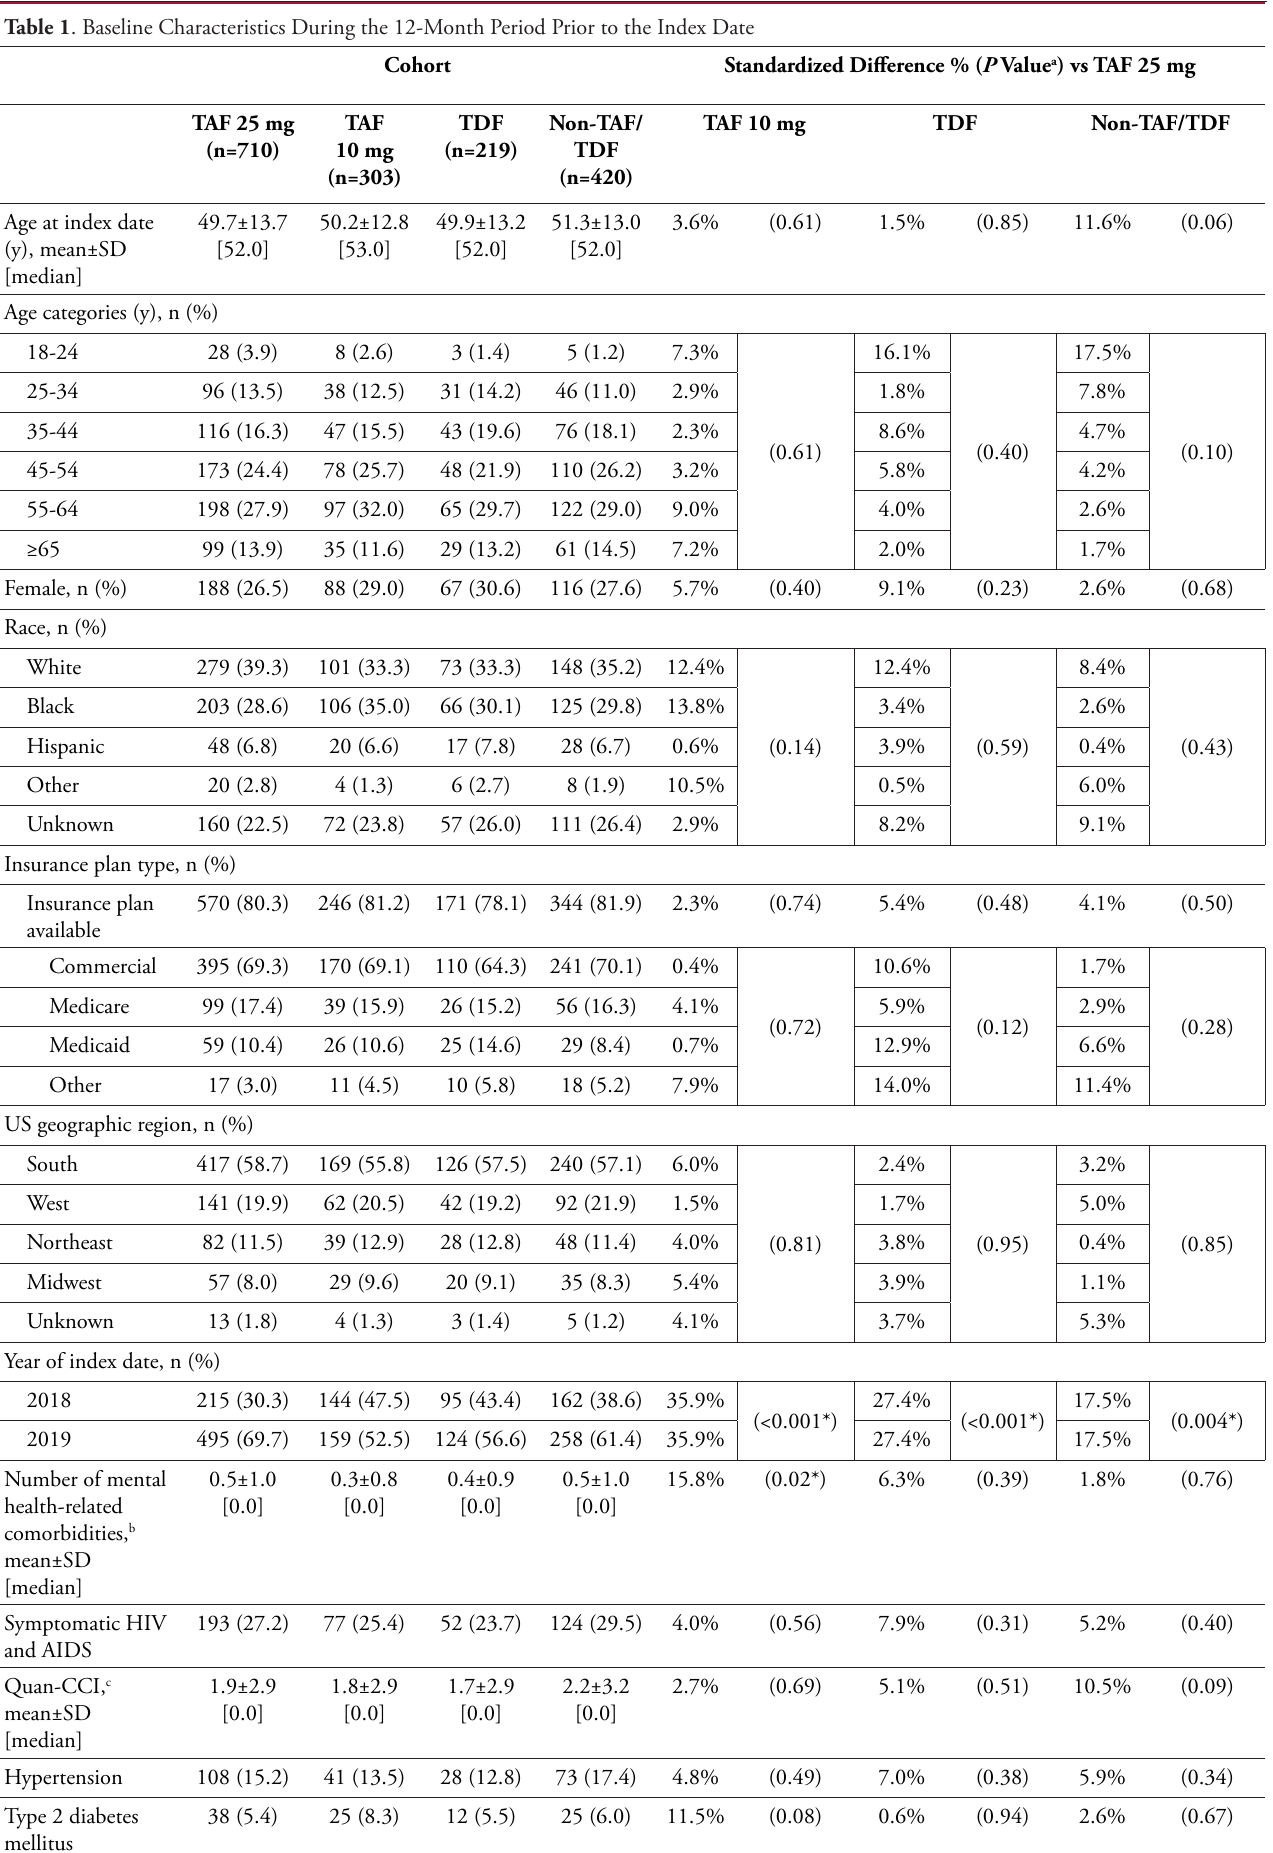
Table 1 . Baseline Characteristics During the 12-Month Period Prior to the Index Date